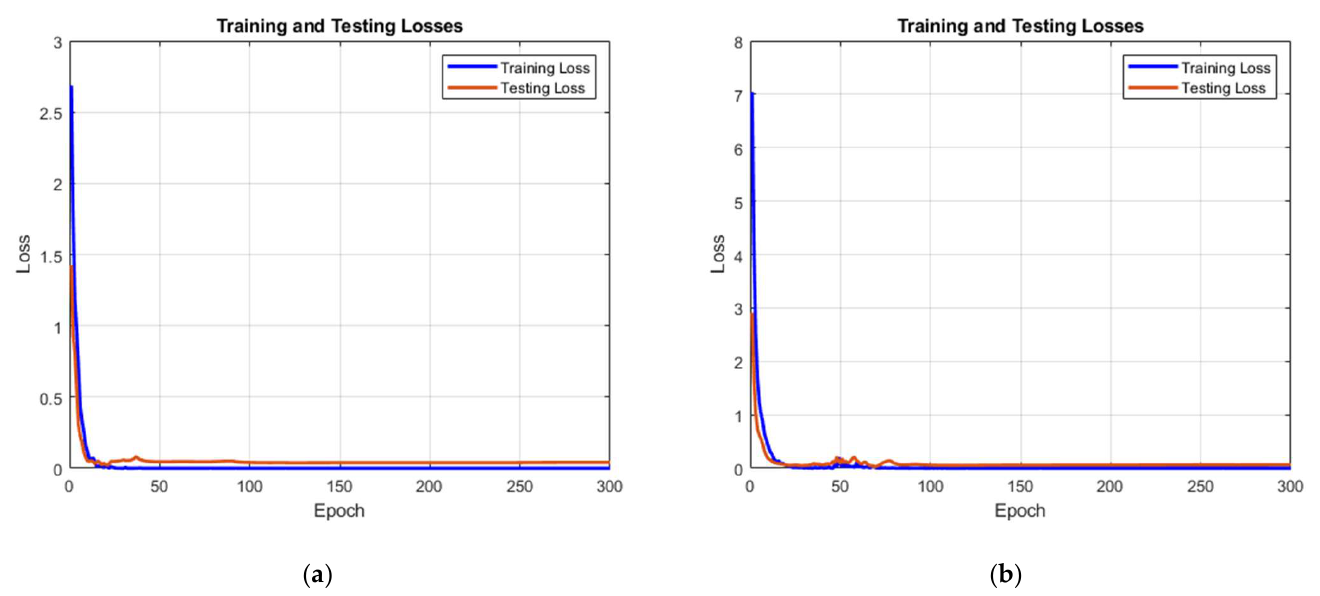
Figure 6. The training and testing losses of the models. ( a ) Training progress of the level 0 model and ( b ) training progress of the level 1 model. Table 2. Comparison of results with the state-of-the-art based on the NEU dataset